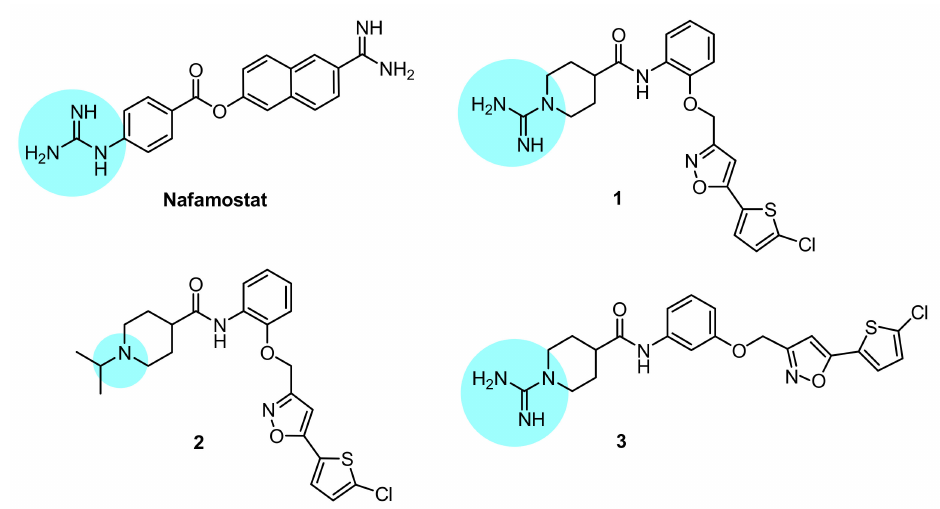
Figure 1. Chemical structures of the compounds investigated in this study; the basic anchoring point of each structure is highlighted with a light blue